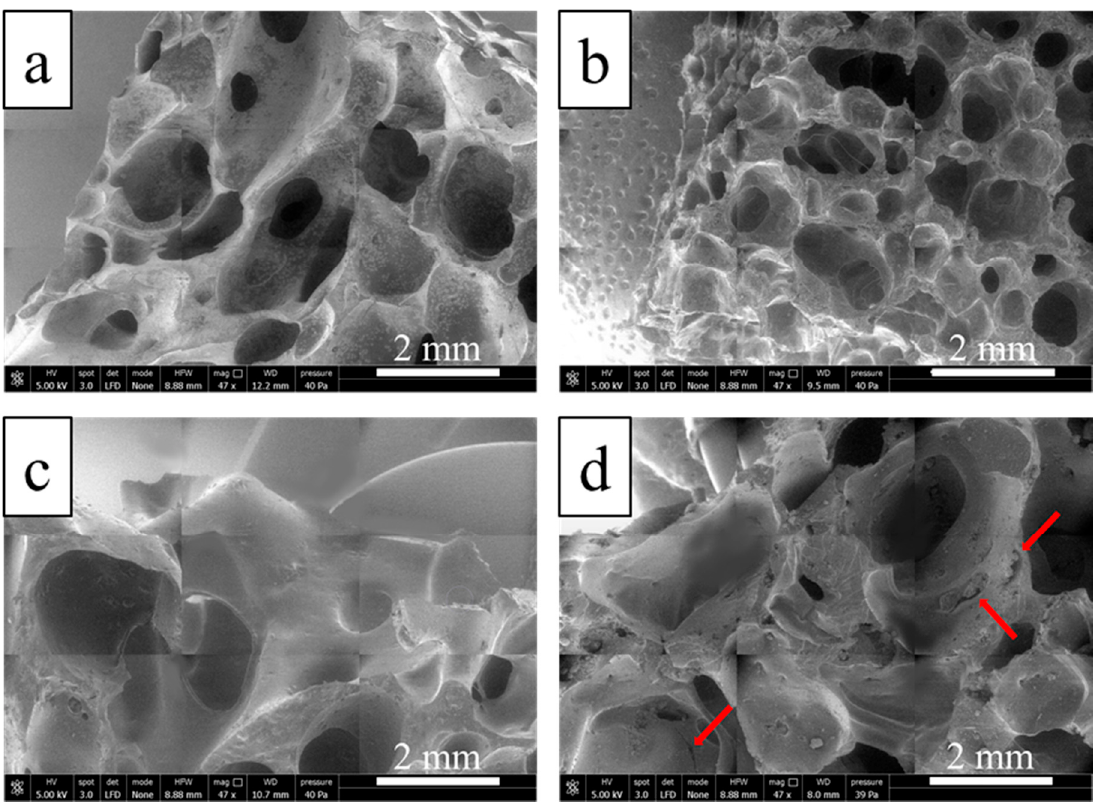
Figure 5. SEM micrographs of composite foams: ( a ) SF-0, ( b ) CNT-0, ( c ) CNT-22, ( d ) CNT-36.